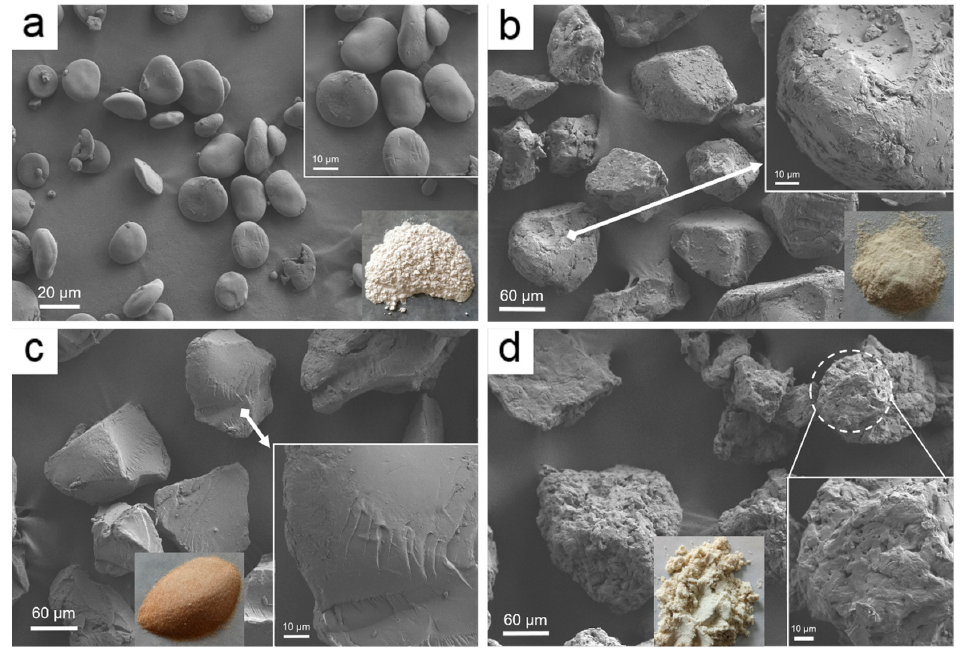
Figure 4. FE-SEM images of ( a ) HBS, ( b ) CEO-SWSM, ( c ) CEO-PM, and ( d ) CEO-UM microcapsules.